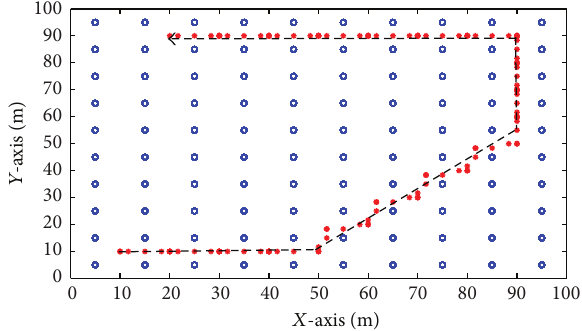
Figure 3: Tracking of moving object with random movement path 2 (black broken lines are the real movements, and red dots stand for predicted object locations).